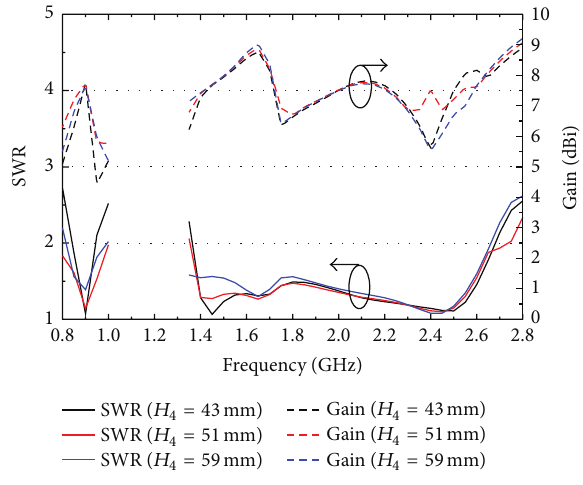
Figure 4: Effects of the height of 𝐻 4 .